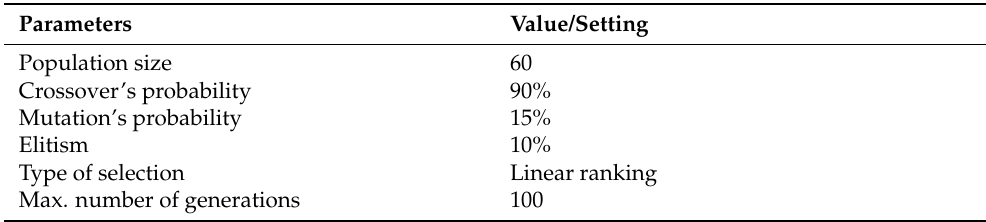
Table 2. The utilized setting parameters for the implemented correlations in this study. Parameters Value/Setting Population